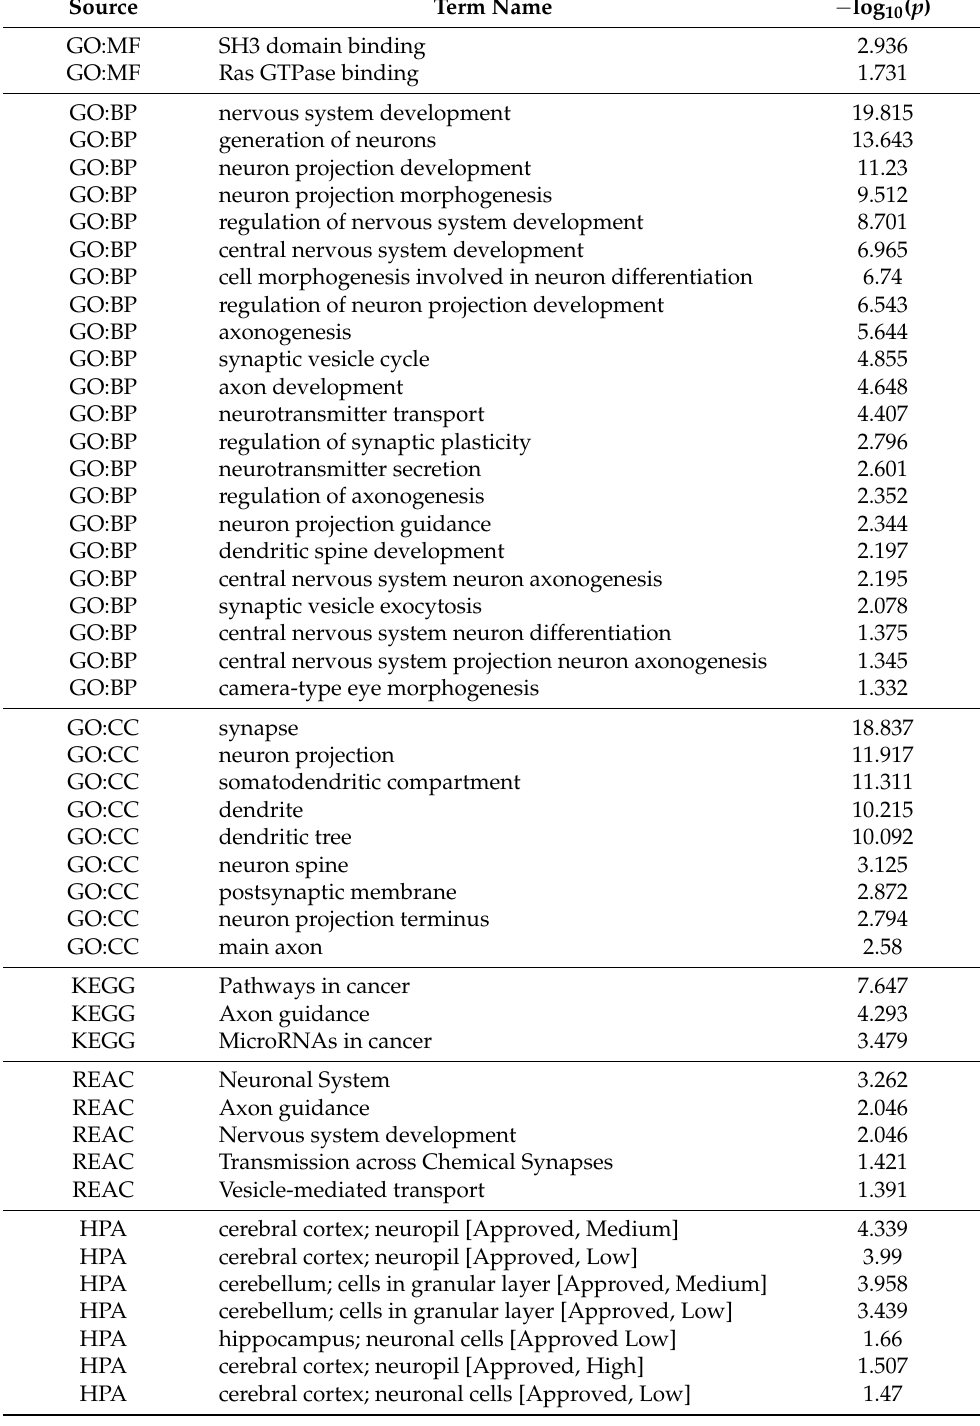
Table 4. The respective functional annotation of the predicted mRNA targets for the co-downregulated miRNAs: MIR149, MIR214, MIR574, MIR595 and MIR765. The colors correspond to the annotation colors presented in Figure 14 (Legend: MF: Molecular Function, BP: Biological Process, CC: Cellular Component, KEGG: KEGG pathway database, REAC: Reactome pathway database, HPA: The Human Protein